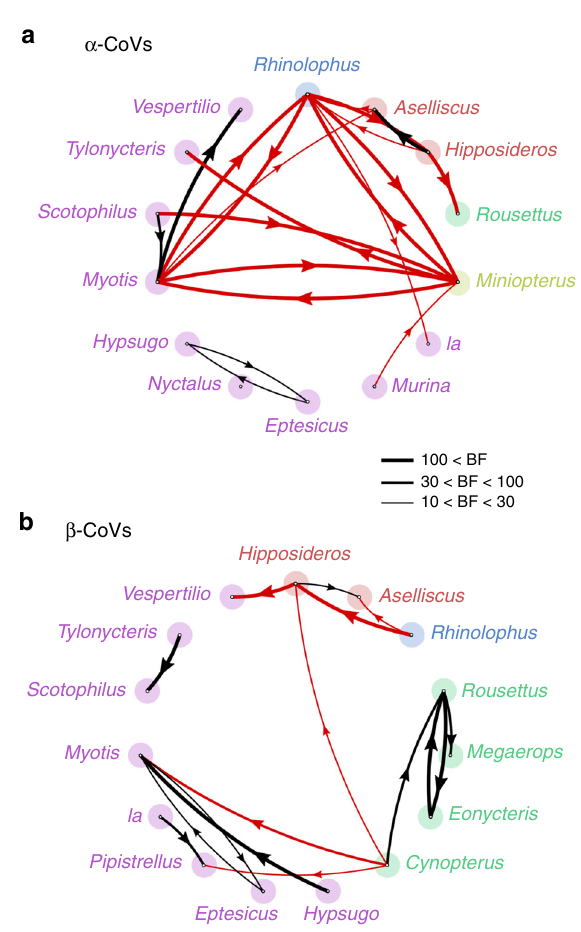
Fig. 5 Inter-genus host switches. Strongly supported host switches between bat genera for α -CoVs ( a ) and β -CoVs ( b ) and their signi fi cance level (Bayes factor, BF). Only host switches supported by strong BF values >10 are shown. Line thickness is proportional to the switch signi fi cance level. Red lines correspond to host switches among bat genera belonging to different families, and black lines correspond to host switches among bat genera from the same family. Arrows indicate the direction of the switch. Genus names are colored according to the family they belong to using the same colors as in Figs. 2 and